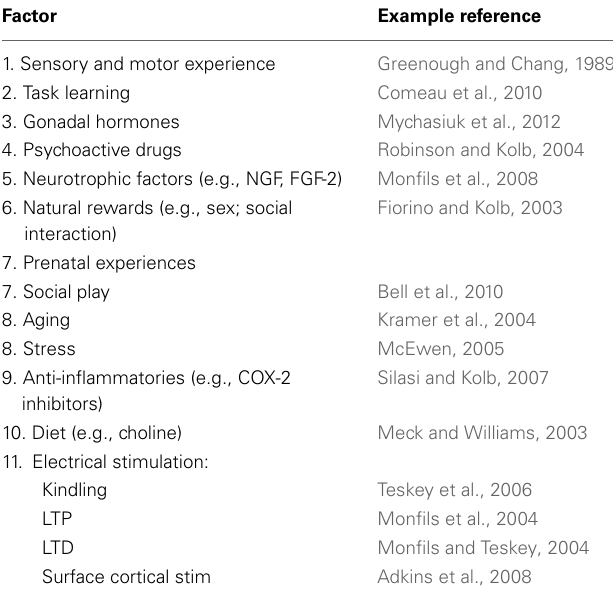
Table 1 | Factors affecting the synaptic organization of the normal